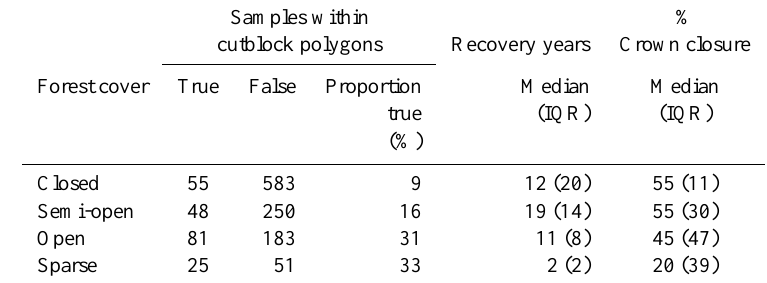
Table 3. Forest cover classification characteristics related to forest cutblock and crown closure inventories.